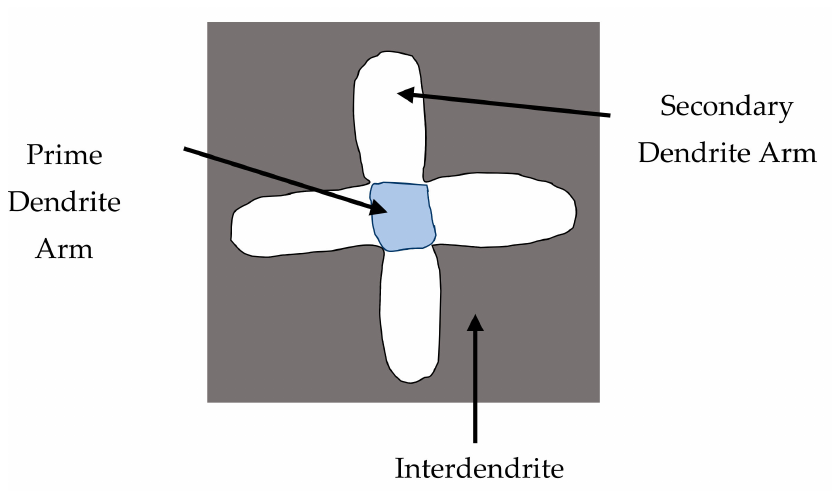
Figure 8. Typical positions selected for quantitative statistics of γ ’ phase distribution.